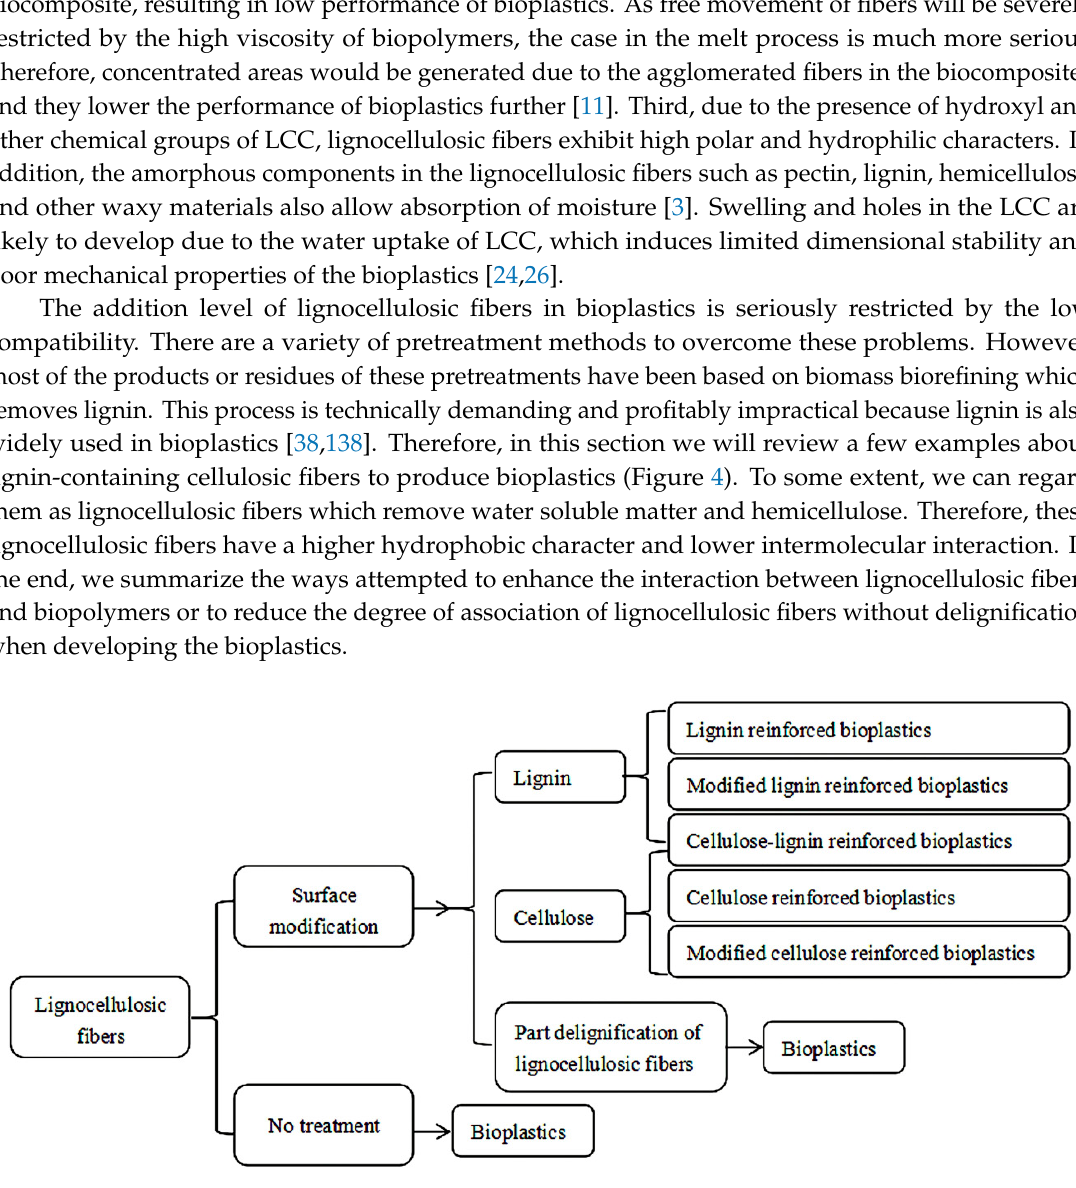
Figure 4. Global scheme of the uses of lignocellulosic fibers and lignin in bioplastics .